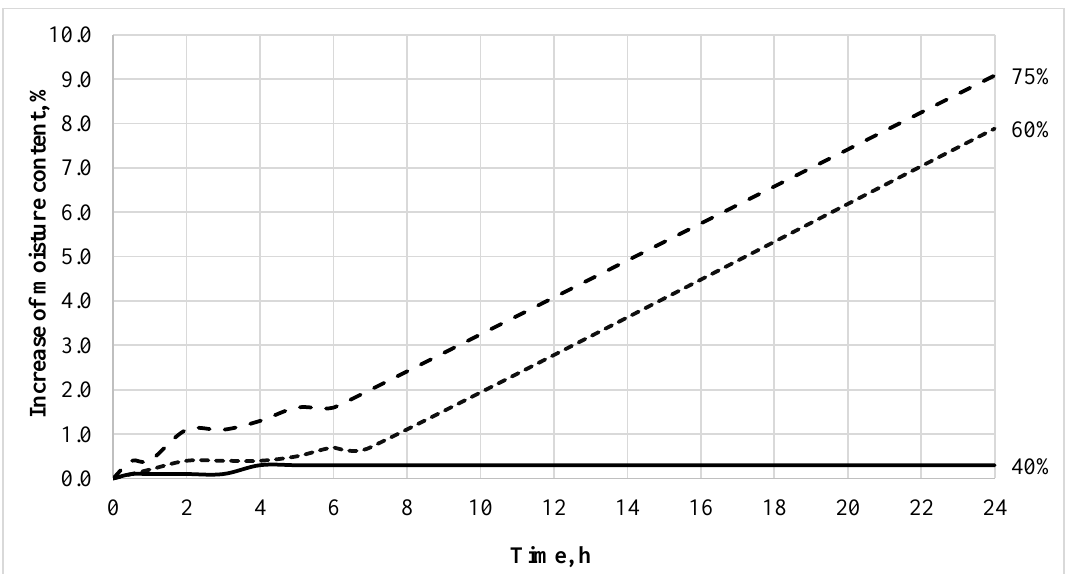
Fig. 6. Moisture absorption of a mixture of granulate lysozyme hydrochloride with ascorbic acid and a composition HiG